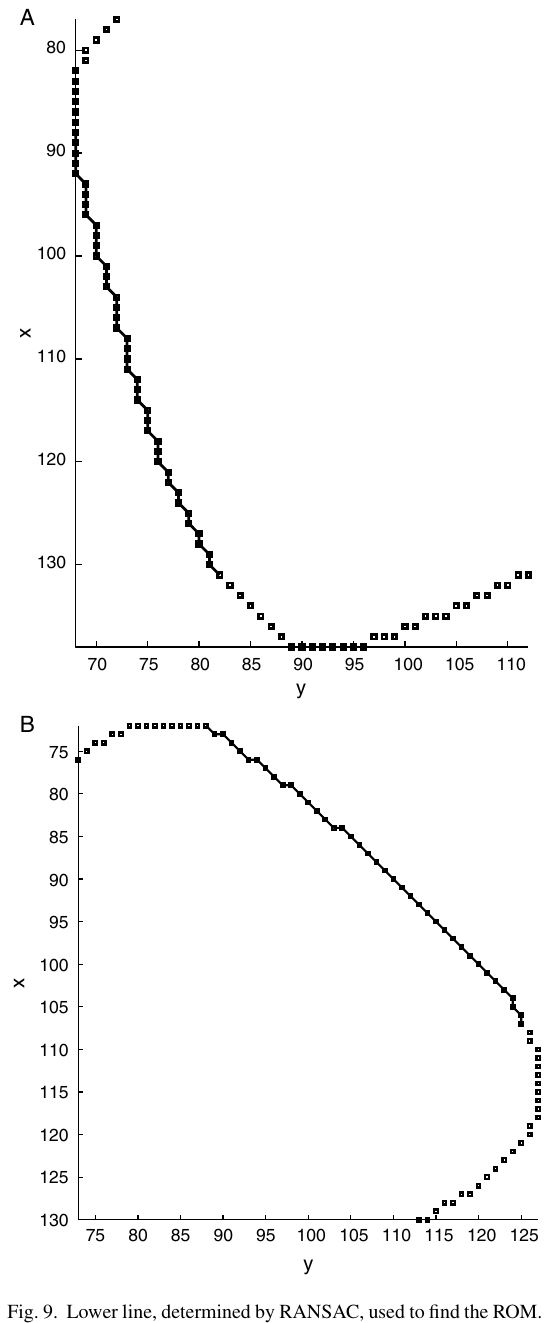
Fig. 9. Lower line, determined by RANSAC, used to find the ROM. (a) Lower line. (b) Upper